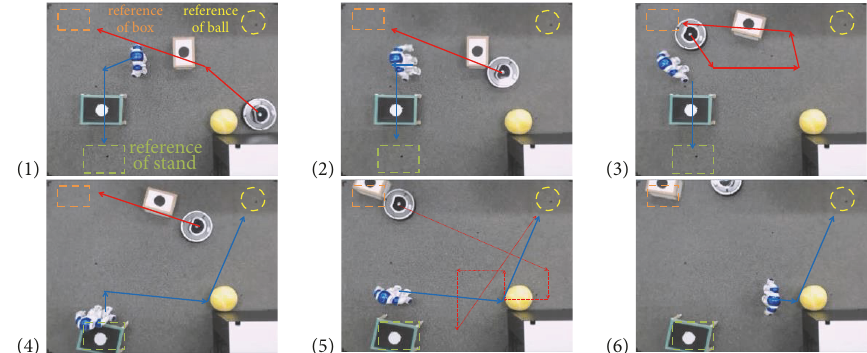
Figure 28: Experiment of real robots based on the proposed method. (1) Initial state. The robot decided the carrying object based on the list of carrying time. (2) Trying to move each object. (3) Roomba fails to carry the box and try to do again. (4) NAO finishes carrying the stand and begins to carry the ball. (5) Roomba finishes carrying the box. The method then determines which robot carries the ball, and NAO continues carrying the ball. (6) Roomba finished tidying, and NAO continues carrying the ball.